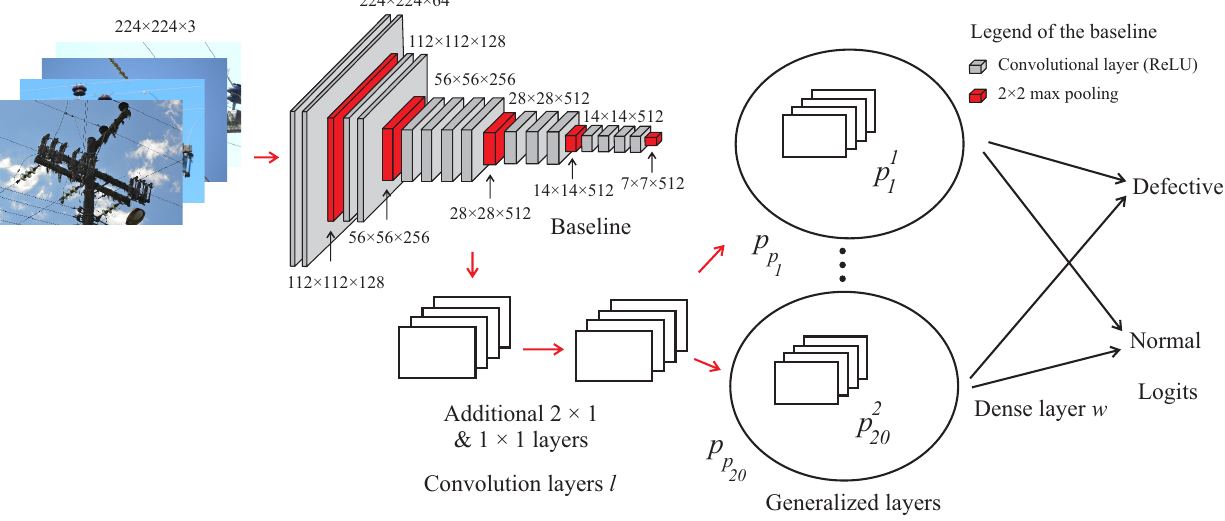
Figure 2. Semi-ProtoPNet